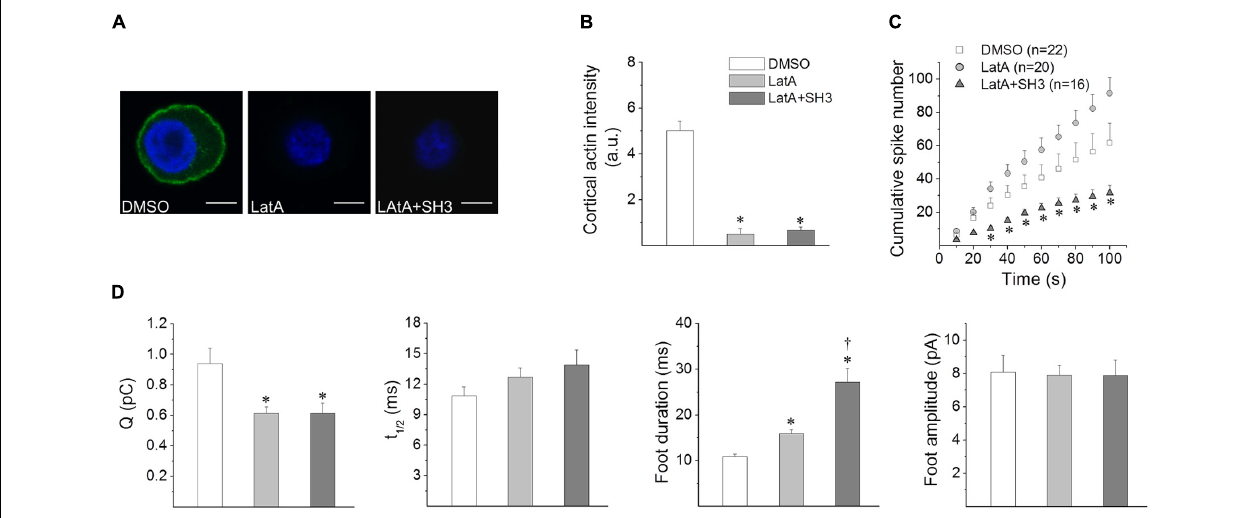
FIGURE 5 | Effects of cortactin SH3 domain on the exocytosis induced in the presence of latrunculin A. (A,B) F-actin polymerization assay was performed in cells permeabilized with 20 µ M digitonin, in the presence of 300 nM Alexa-Fluor-488 actin, 2 mM ATP-Mg 2 + , 10 µ M free Ca 2 + and the vehicle DMSO, 2 µ M latrunculin A (LatA) or 2 µ M LatA plus GST-cortactin SH3 (LatA+SH3). Then samples were fixed, stained with DAPI and visualized by confocal microscopy. (A) Representative images of F-actin formation. Scale bar = 10 µ m. (B) The graph corresponds to quantification of the fluorescence intensity of cortical F-actin (1 µ m under the cell periphery), where data are means ± SEM of 10–16 cells from three different cultures. ∗ p < 0.05 compared to DMSO (one-way ANOVA followed by unpaired t -test). (C,D) Cells were incubated for 10 min with 2 µ M LatA or DMSO. A group of cells were injected with GST-cortactin SH3 20 min before LatA treatment (LatA+SH3). Exocytosis was induced with 50 µ M DMPP and monitored by amperometry. The amperometric recordings lasted 100 s. (C) Cumulative histograms of the number of amperometric events from cells treated with DMSO (white squares), LatA (gray circles) or LatA+SH3 (dark-gray triangles). Numbers between parentheses indicate the number of cells analyzed from at least three different cultures. ∗ p < 0.05 compared to DMSO (one-way ANOVA followed by unpaired t -test). (D) The graphs show mean values of medians determined for single cells of quantal size (Q), half width (t 1 / 2 ), foot duration and foot amplitude of amperometric spikes from cells treated with DMSO (white bars), LatA (gray bars) or LatA+SH3 (dark-gray bars). Data are represented as means ± SEM. Numbers of cells for each condition are the same as indicated in (C) . ∗ p < 0.05 compared with DMSO, † p < 0.05 compared with LatA (one-way ANOVA followed by unpaired t